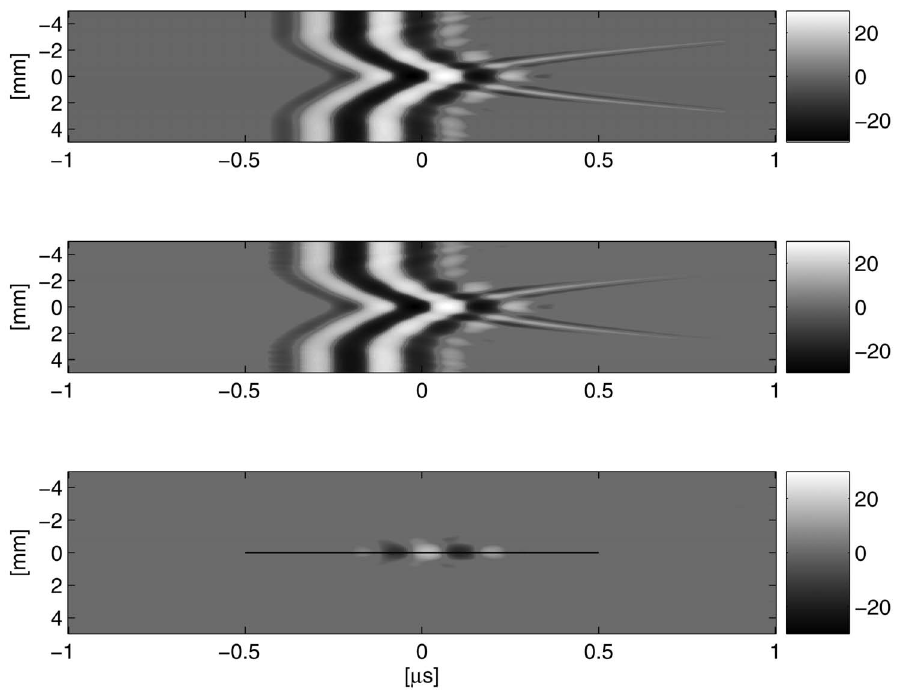
Figure 7. Comparison of the forward propagating wave fronts for the pseudo-differential model and the full wave equation recorded at 8.9 mm. Top: solution of the full wave equation. Middle: solution of the one-way wave equation. Bottom: difference between the two solutions. The line in the bottom picture indicates the location where the crosssection shown in Figure 8 is made. A (cid:6) 30 dB logarithmic grey scale is used in the display.